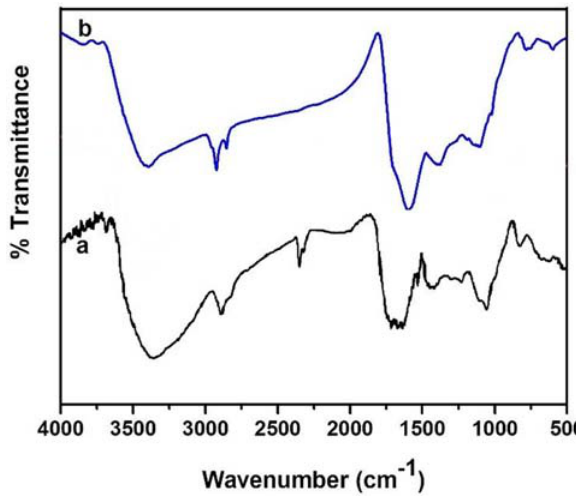
Figure 3. FTIR spectra of (a) A.comosus fruit extract and (b)